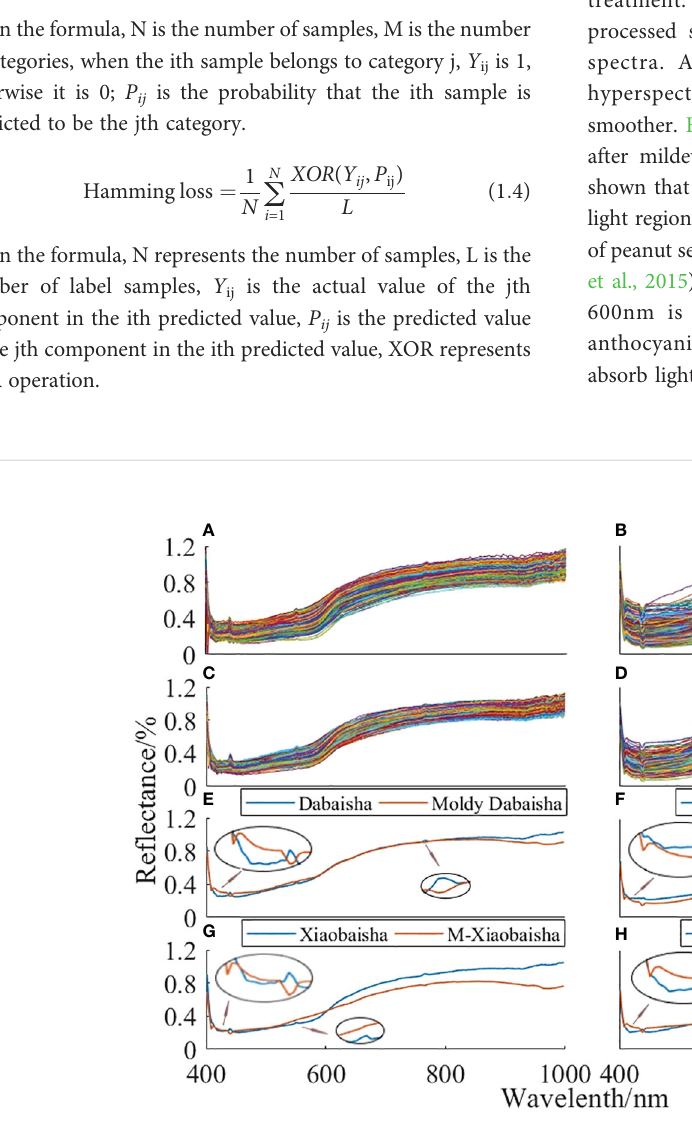
FIGURE 4 Spectral curves of peanut seeds. (A) The original spectral curves of four varieties of peanut seeds; (B) the original spectral curves of mildewed peanut seeds; (C) the spectral curves after MF pretreatment; (D) spectral curves of moldy peanut seeds after MF pretreatment; (E – H) are the average spectral curves of four healthy peanut seeds and moldy peanut seeds,